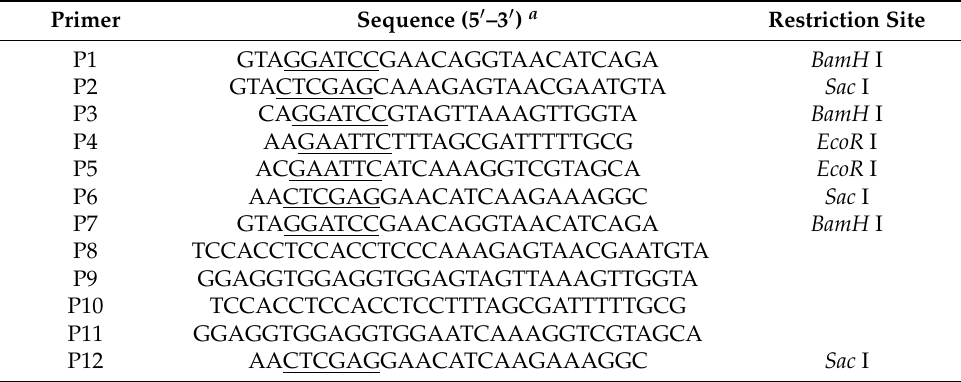
Table 1. Primers used for amplify mrp , gapdh , dld , and gapdh - mrp - dld . Primer Sequence (5 (cid:48) –3 (cid:48) )